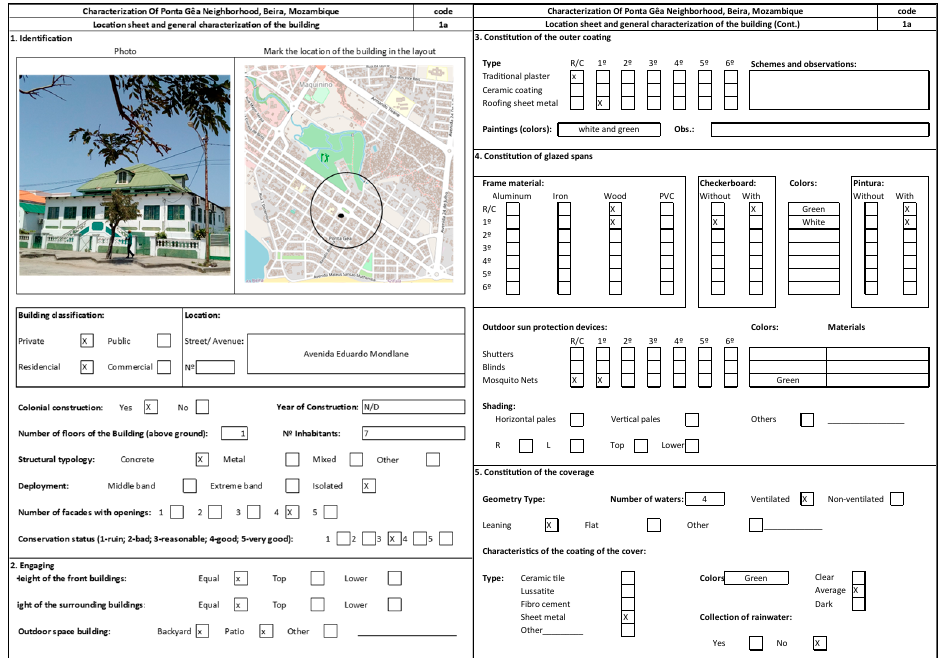
Figure 5. Survey forms for the preliminary characterization of buildings: general characterization of buildings.